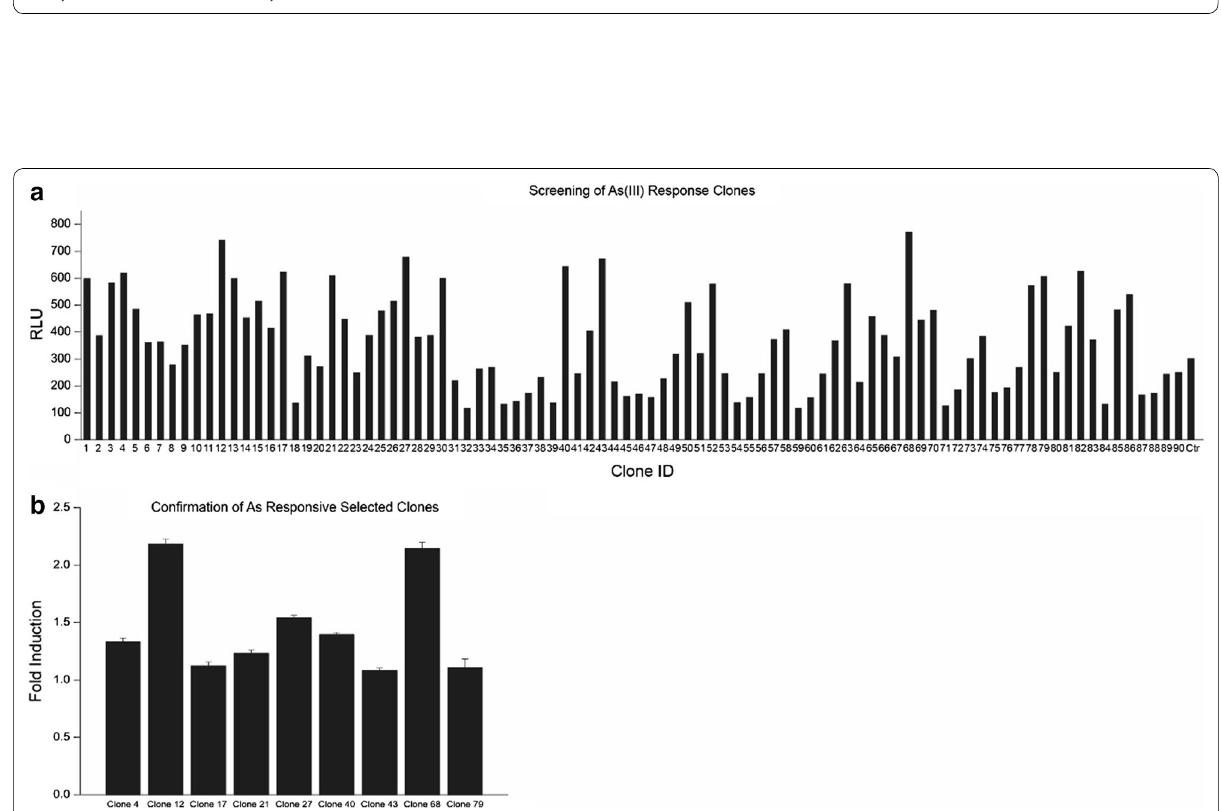
Fig. 4 Directly functional screening of arsenite-responsive clones. Ninety clones from library were randomly selected, cultured with 5 μM arsenite treatment for 2 h, and subject to luciferase analysis ( a ). Nine clones with luciferase activities > 600 RLU were then selected for arsenite induction assay ( b